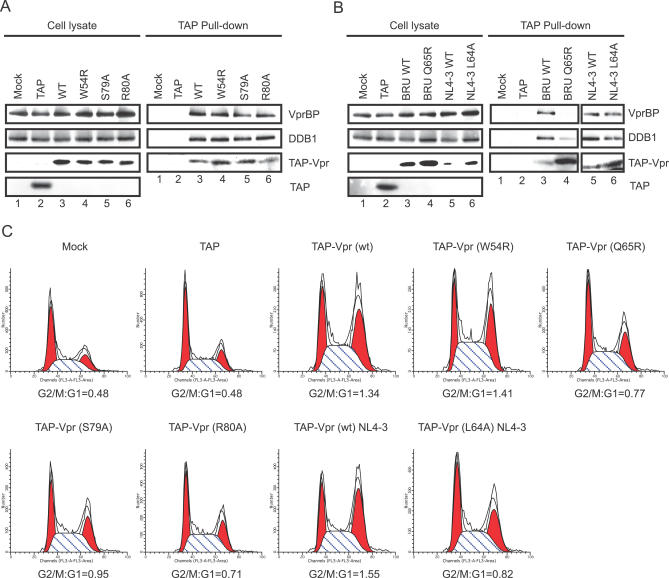
DDB1 and VPRBP Binding Affinities of TAP-Tagged Vpr Mutants(A) HEK293T cells were transfected with TAP-Vpr plasmids encoding for wild-type Vpr (lanes 3) or Vpr mutants W54R (lanes 4), S79A (lanes 5), and R80A (lanes 6). As control, cells were mock transfected (lanes 1) or transfected with a TAP-expressing plasmid (lanes 2). Following TAP pull-down using IgG-coupled beads, the levels of endogenous VPRBP and DDB1 were monitored in crude lysates and pulled-down fractions by Western blot using specific antibodies. TAP, TAP-Vpr, and cleaved Vpr were detected using a polyclonal rabbit antibody directed against a Vpr N-terminal peptide.(B) HEK293T cells were transfected with TAP-Vpr plasmids encoding for wild-type Bru Vpr (lanes 3) and wild-type NL4–3 Vpr (lanes 5), or Vpr mutants Bru Q65R (lanes 4) and NL4–3 L64A (lanes 6). As control, cells were mock transfected (lanes 1) or transfected with a TAP-expressing plasmid (lanes 2). TAP pull-downs and immunodetection of VPRBP, DDB1, TAP, and Vpr were performed as described for (A).(C) HEK293T cells were co-transfected with 1 μg of GFP-expressing plasmid and 15 μg of TAP-Vpr plasmids expressing wild-type or mutant proteins. Cell cycle analysis was performed using propidium iodide staining on the GFP+ cell population as described in Materials and Methods. Percentages of G1 and G2/M cell populations were determined using the ModFit software.